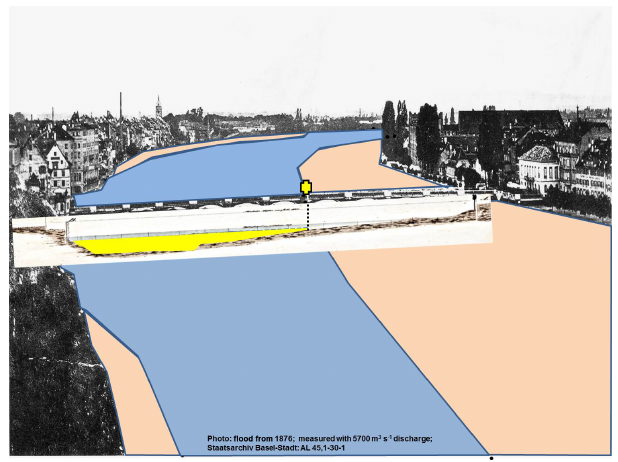
Figure 4. Reconstructed Rhine River channel during the peak of the perennial drought in 1540.